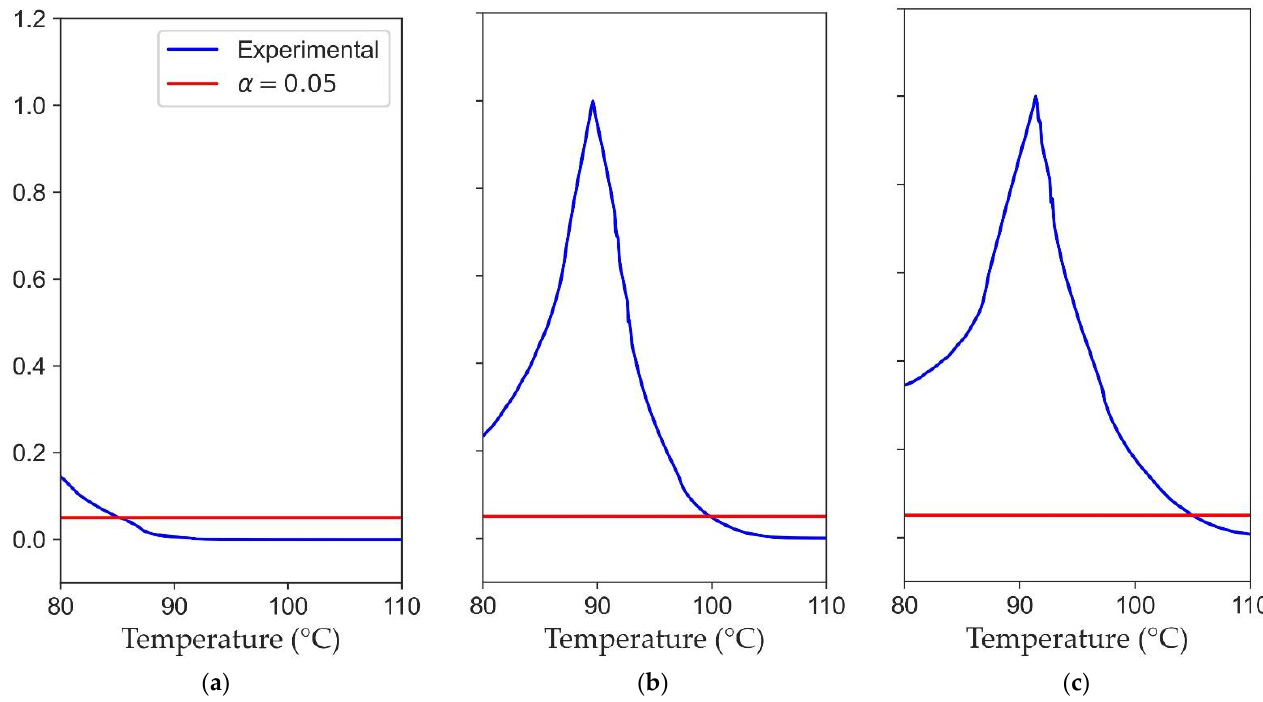
Figure 13. T-student test for Highly Diluted Octane in Water Experiments ( a ) 0.1%wt octane, ( b ) 0.25%wt octane, ( c ) 0.5%wt octane.